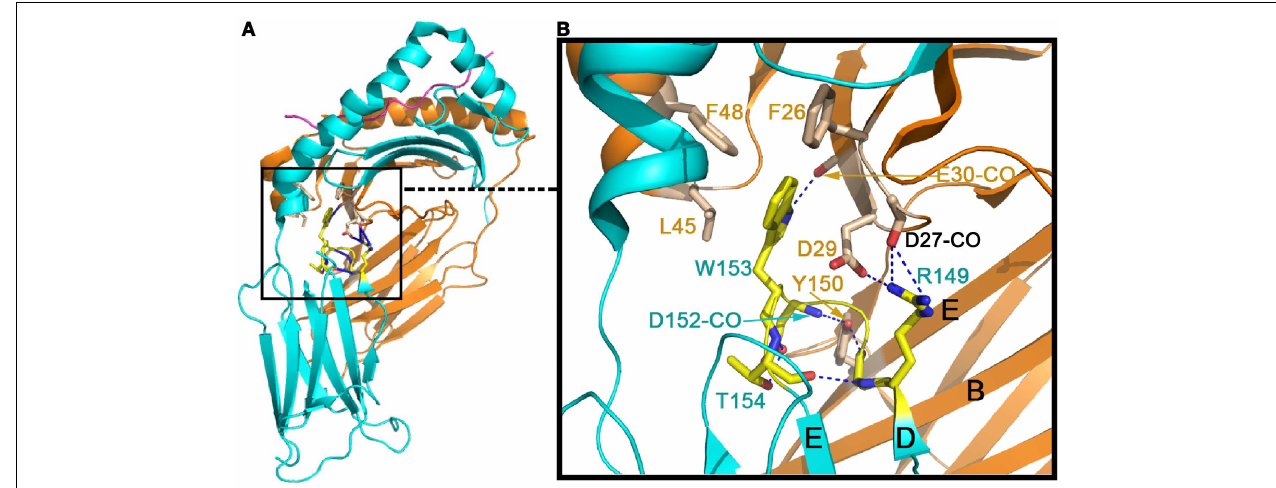
chain whereas the cyan color defines the β chain. (B) Zoomed-in view of detailed inter-domain interaction involving particularlyW153 at the β chain’s